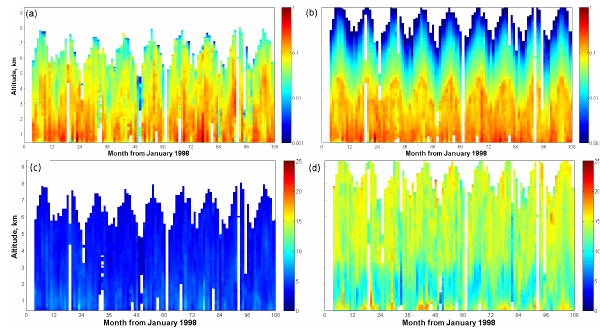
Fig. 3. Vertical profiles of monthly mean cloud LWC and droplet effective radius ( r e ) from the MICROBASE and UU products at the SGP site for the period of 1998 to